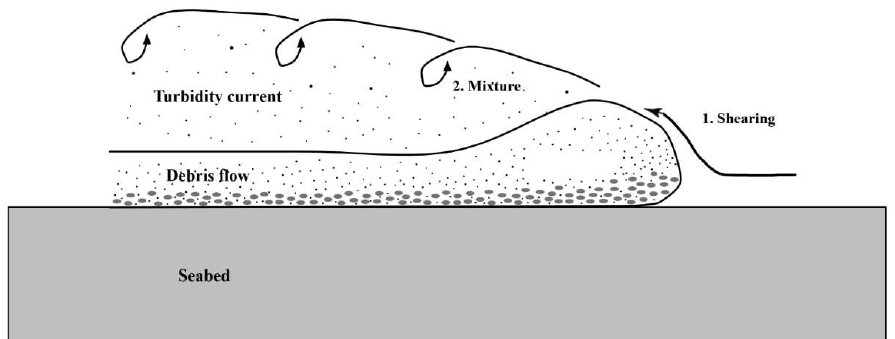
Figure 2. Transformation of the debris flow into the turbidity current.